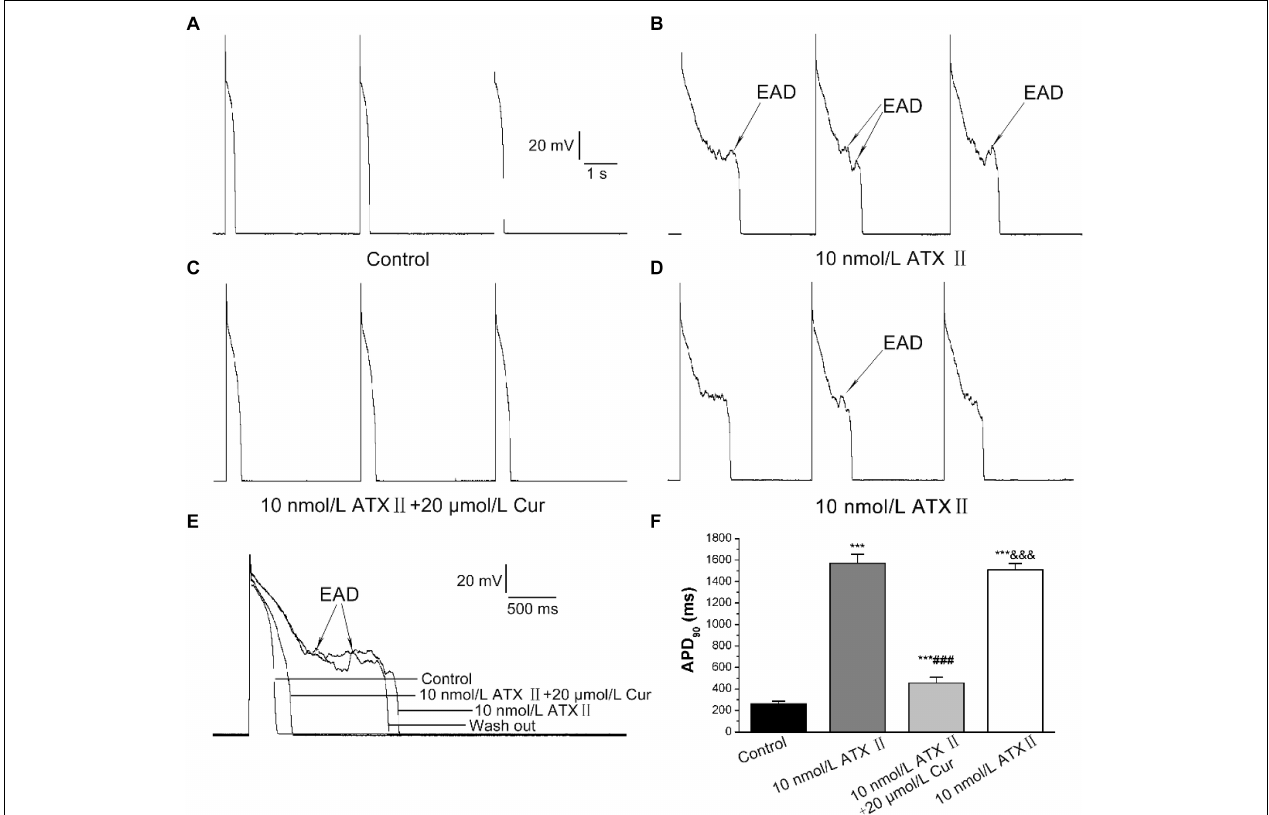
FIGURE 5 | The antagonistic effects of Cur on the prolonged APD and early afterdepolarization (EAD) in ventricular myocytes. (A–D) Example records of APs with a train-of-three stimulation at a lower frequency of 0.25 Hz for the control group, ATX II group, Cur-treated group, and wash out group, respectively. (E) Example records of single APs at a frequency of 0.25 Hz on the different groups. (F) The comparison of average APD 90 values of four groups ( n = 11, *** P < 0.001 vs. control; ### P < 0.001 vs. 10 nmol/L ATX II; &&& P < 0.001 vs. 10 µ mol/L ATX II with 20 µ mol/L Cur).